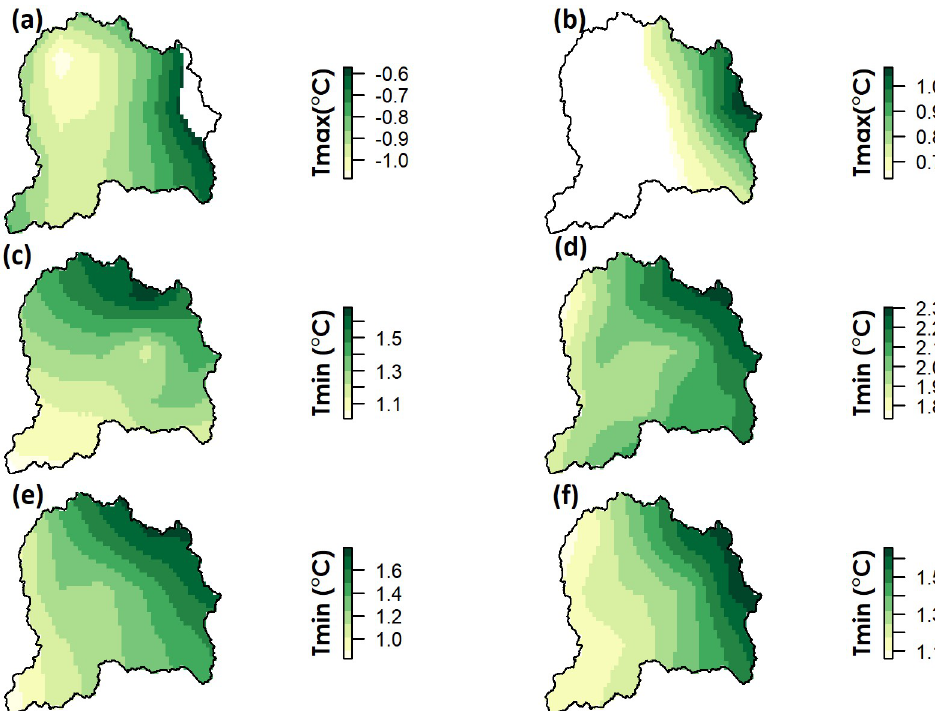
Fig 6. Seasonal trends in Tmax and Tmin over the 34 years period. All p-values greater than 0.05 are masked and only statistically significant (p < 0.05) trends are presented. (a) significant trends in Tmax during Q3, (b) significant trends in Tmax during Q4 (c) significant trends in Tmin during Q1 (d) significant trends in Tmin during Q2 (e) significant trends in Tmin during Q3 and (f) significant trends in Tmin during Q4. https://doi.org/10.1371/journal.pone.0271991.g006 line with a reduction of vegetation in the permafrost across Tibetan plateau [73]. However, a reduction in HV in the UJRB could be related to an increase in anthropogenic activity.